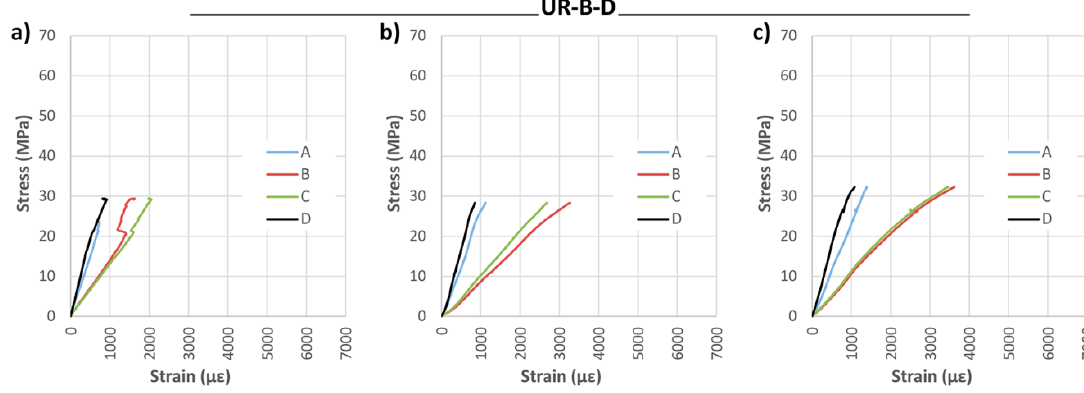
Figure 17. Stress against strain during bending tests: ( a ) UR-B-D-1; ( b ) UR-B-D-2; and ( c ) UR-B-D-3. CFRP supplier: DRIZORO ® .